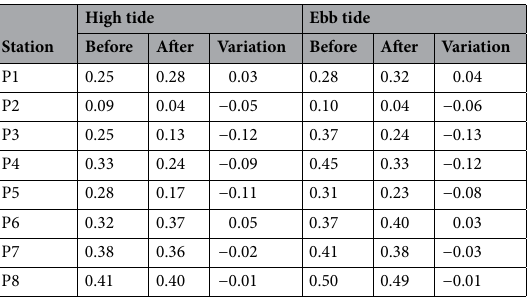
Table 2. Comparison of velocity at the representative station before and after the project.